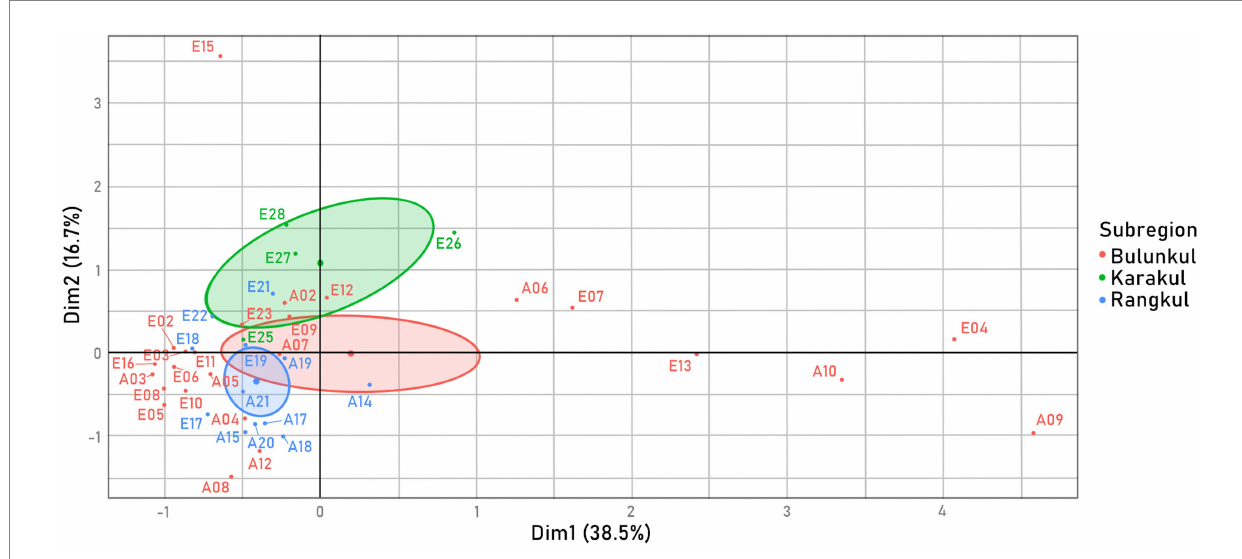
FIGURE 2 Variability of samples, MFA calculated from two factor groups: environmental parameters measured in situ (temperature, pH, salinity); and concentration of nutrients in reservoirs measured ex situ (total organic C, total N, total P, PO 43 − , NH 3+ , NO 2 − + NO 3 − , Na + , K + , Ca +2 , Mg +2 ). The 41 samples were colored by a supplementary factor group: subregion, which was not included in the samples’ placement calculations.